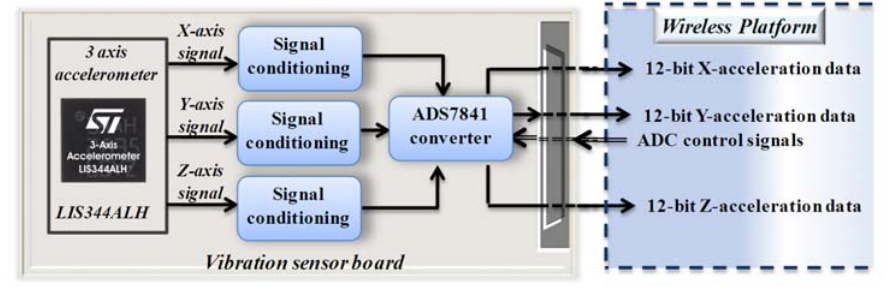
Figure 9. Block diagram for 3-Axis Accelerometer